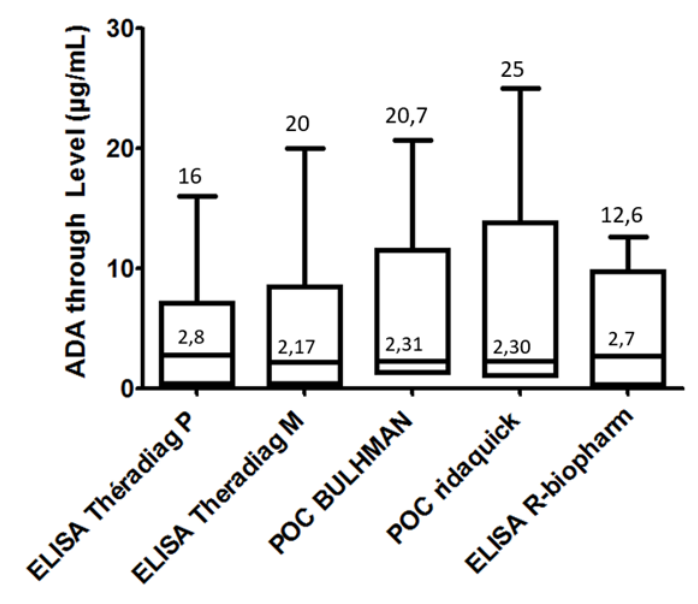
Figure 1. Measure of ADA trough level distribution determined with the different assays. The lines in the boxes represent the median value (µg/mL). POC-Point of Care; ADA: adalimumab.